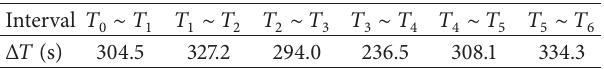
Table 7: Flight time in each trajectory interval (Case 2).